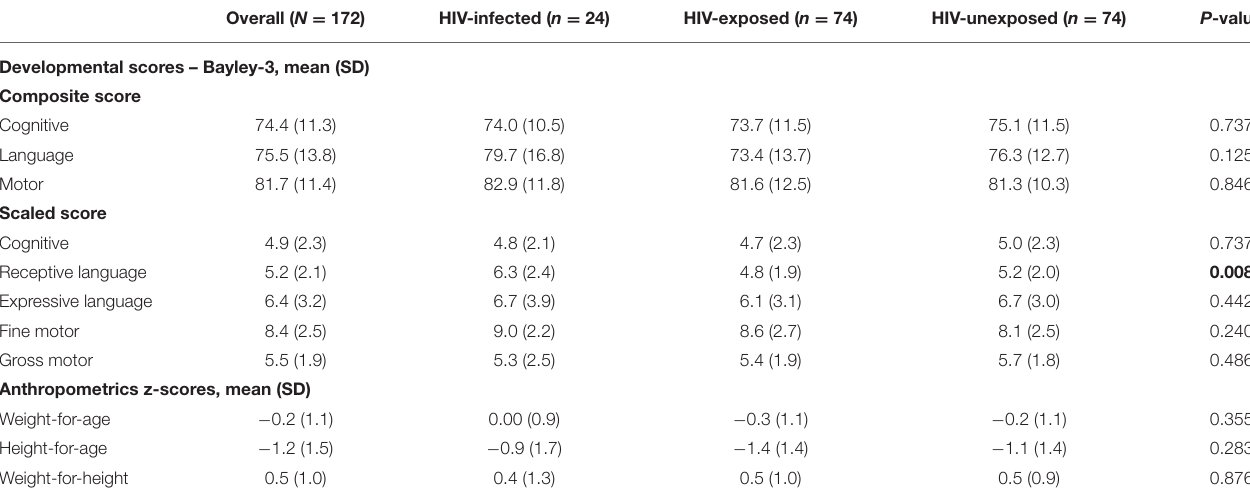
TABLE 2 | Developmental scores and anthropometrics of study population, aged 18–36 months, by HIV status. Overall ( N = 172) HIV-infected ( n =